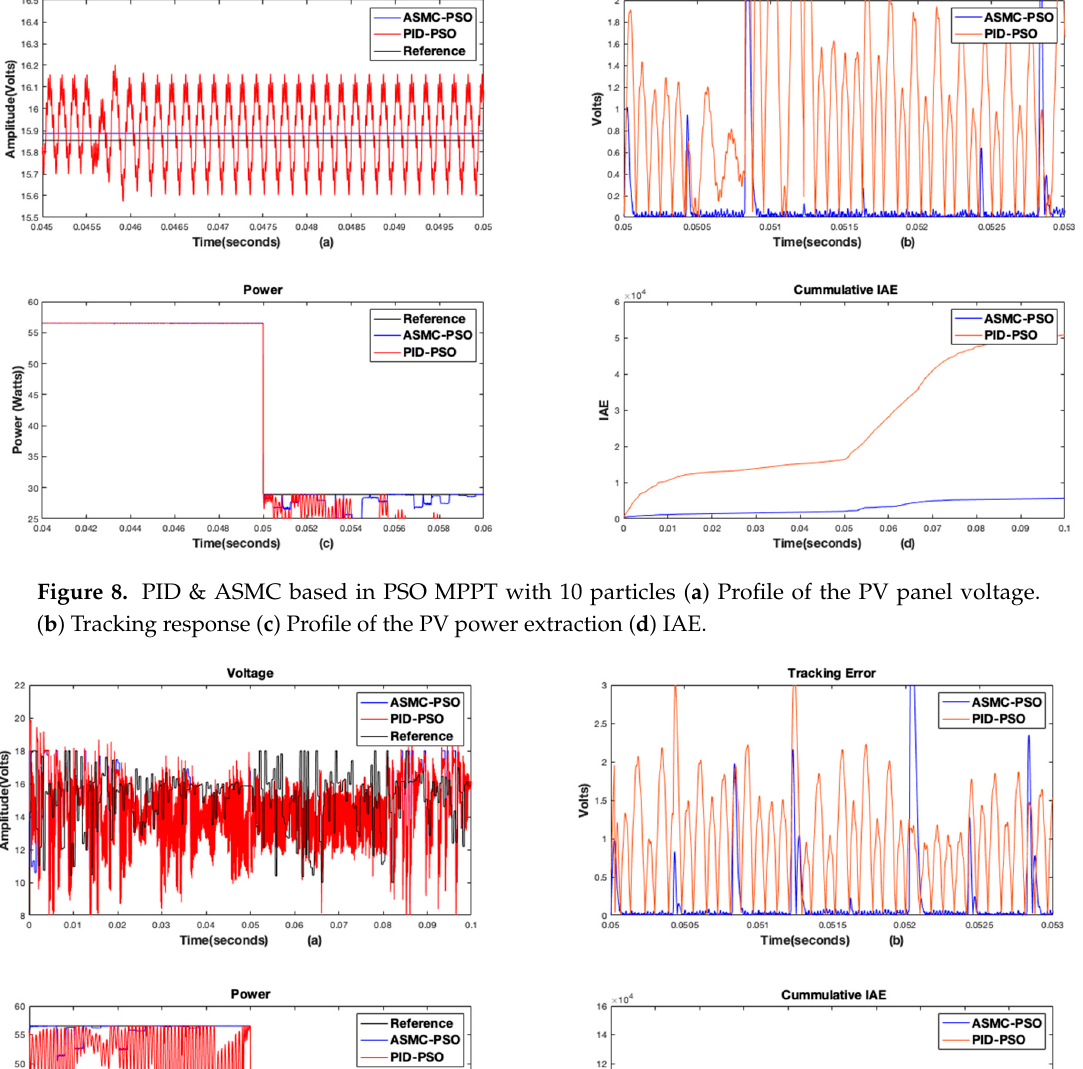
Table 5. Performance characteristics of the conventional controller and the proposed ASMC controller based on PSO 40 particles.